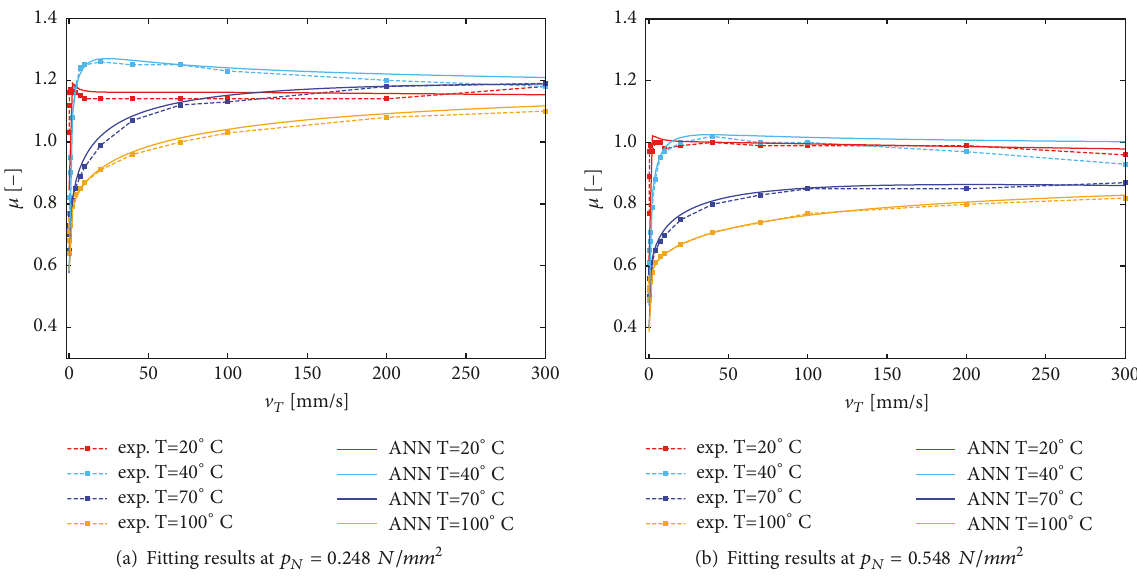
Figure 4: Frictioncoefficient 𝜇 provided byANNversusexperimentalresultatnormal pressure 𝑝 𝑁 = 0.248 𝑁/𝑚𝑚 2 and 𝑝 𝑁 = 0.548 𝑁/𝑚𝑚 2